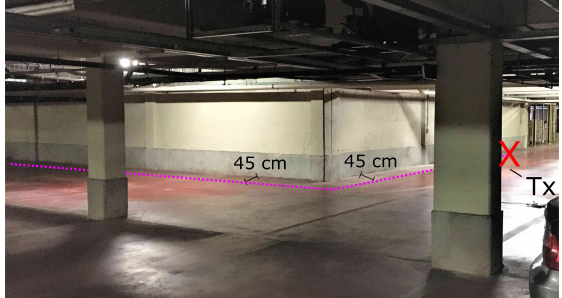
Figure 5. Scenario WOC: View of the outside corner. The Tx is indicated by the red X. The measurement path is represented by the dashed purple line. The underground parking garage was almost completely empty at the time of the